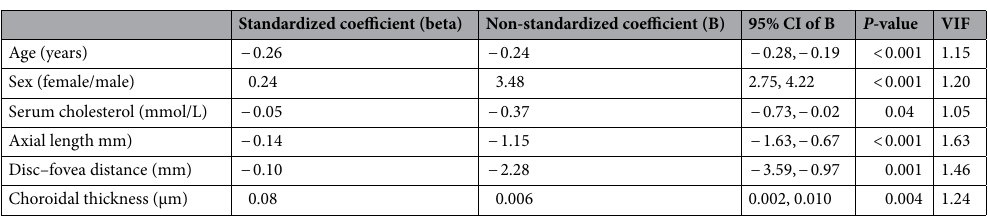
Table 3. Associations between the thickness of the retinal outer nuclear layer (ONL) with ocular and systemic parameters in a multivariable analysis. The layer thickness was calculated as the mean value of all 9 Early Treatment Diabetic Retinopathy Study (ETDRS) subfields. CI confidence interval, VIF variance inflation factor.